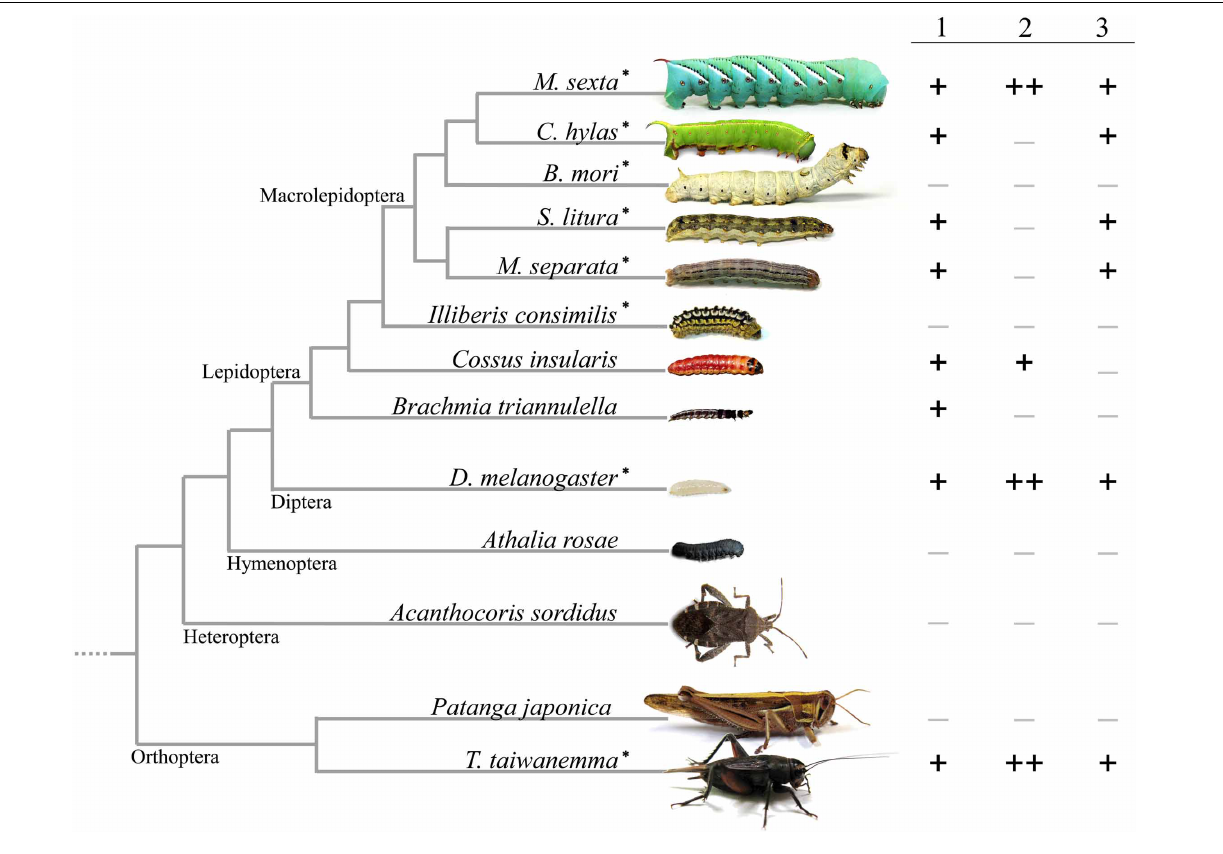
had only this type of FACs, suggesting this might be the evolutionarily older FACs. ++ : major components, + : components constantly detected, − : not detected. ∗ : insect species used in this